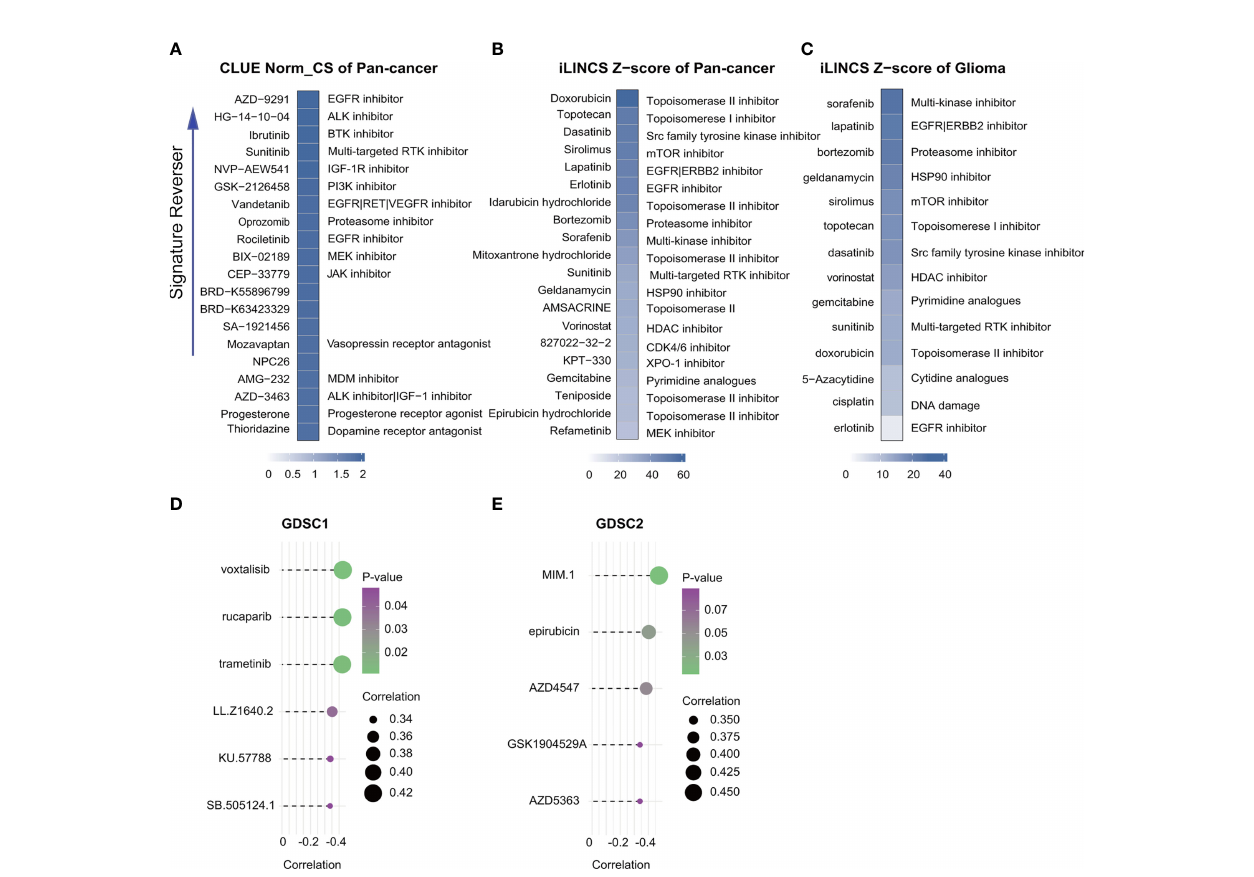
FIGURE 9 | Drug connectivity analysis using alteration-speci fi c transcriptional (CLUE and iLINCS). Pan-cancer in CLUE (A) , pan-cancer in iLINCS (B) , and glioma in iLINCS (C) identifying 20 compounds that enhance or reverse the signature (highlighted with documented mechanisms). Compounds showing negative correlations with AUC values and FRG scores for glioma cells were identi fi ed from GDSC1 and GDSC2. (D, E)